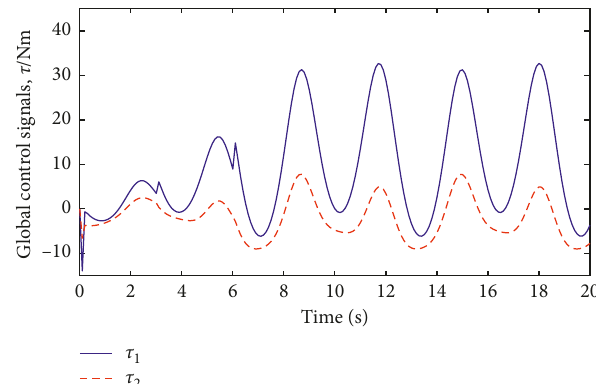
Figure 13: Global control signals for the manipulator with jumping